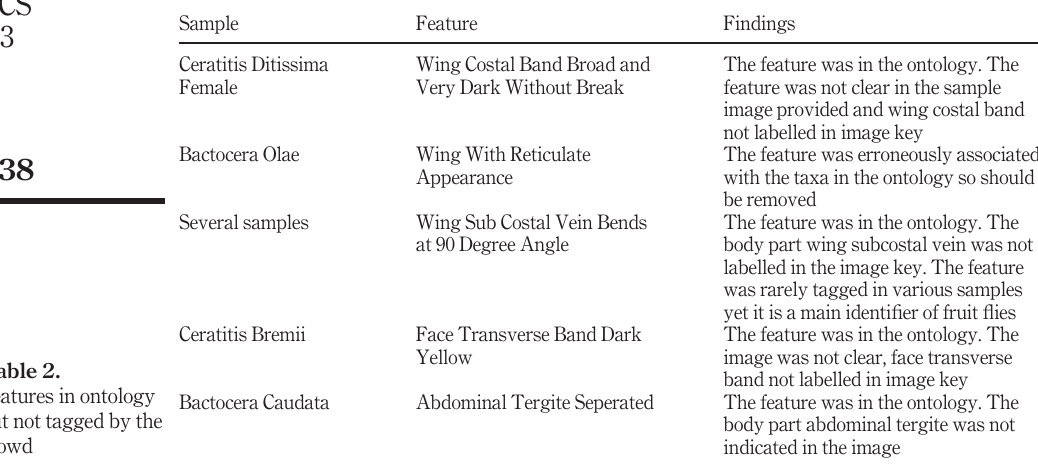
Table 2. Features in ontology but not tagged by the